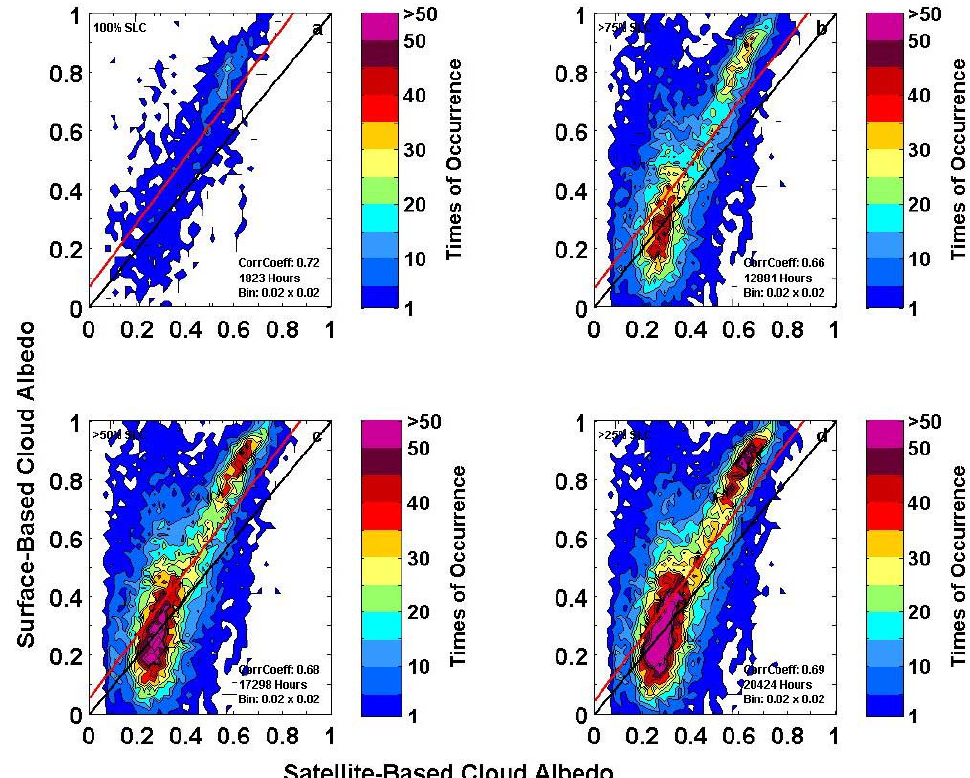
Fig. 6. Same as Fig. 1, except that each plot represents different percentage of the occurrence of single layer clouds.